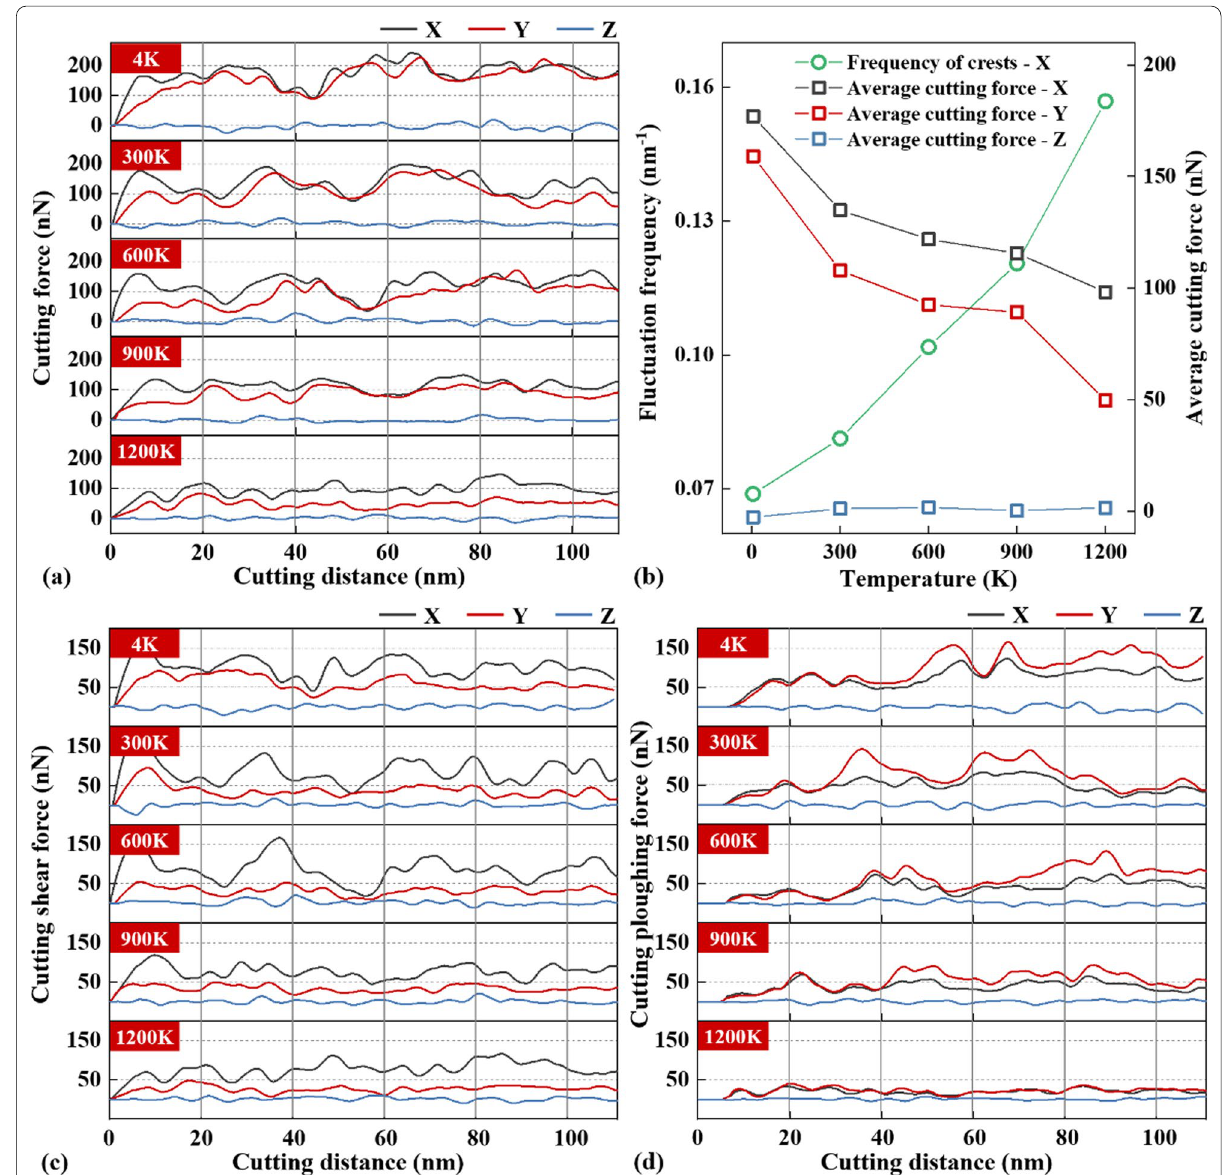
Fig. 10 Characteristics of cutting forces at different temperatures, a cutting force, b average cutting force and fluctuation frequency, c cutting shear force, d cutting plowing